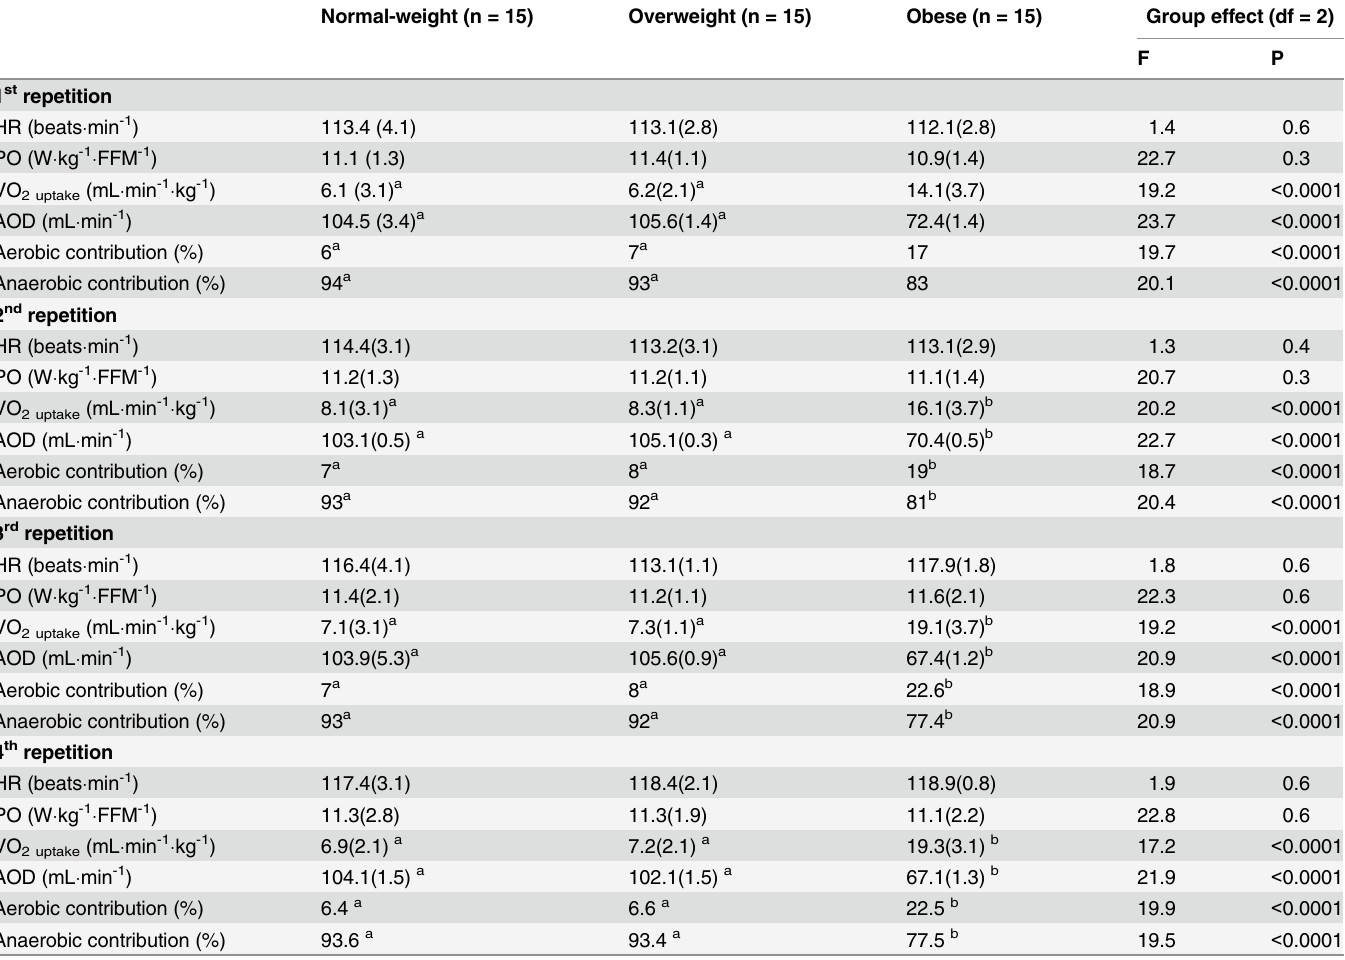
Table 3. Variables obtained during the supramaximal cycling